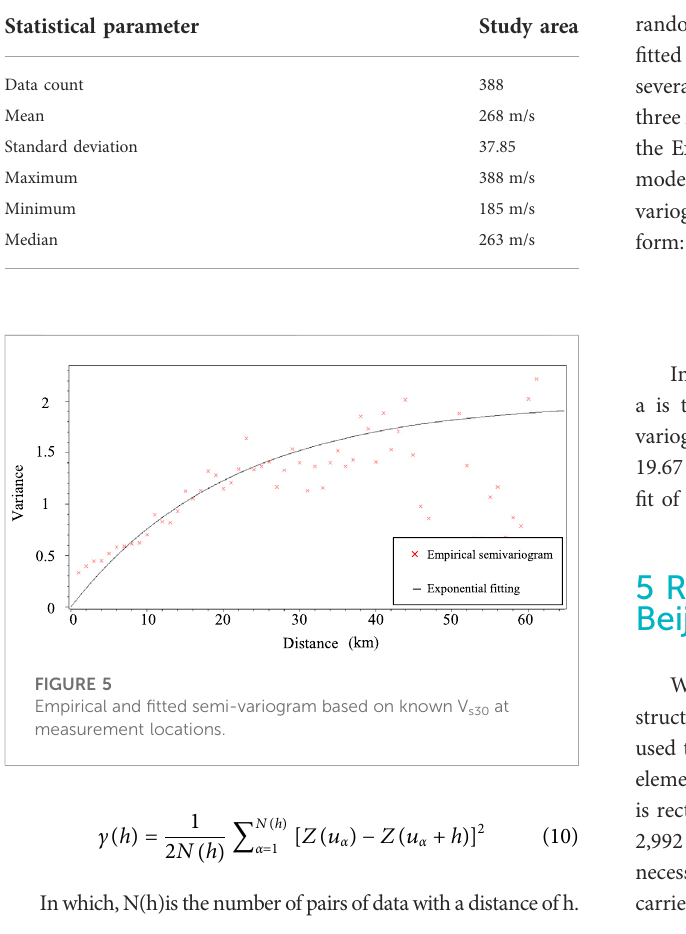
TABLE 1 Statistical characteristics of the known V s30 .